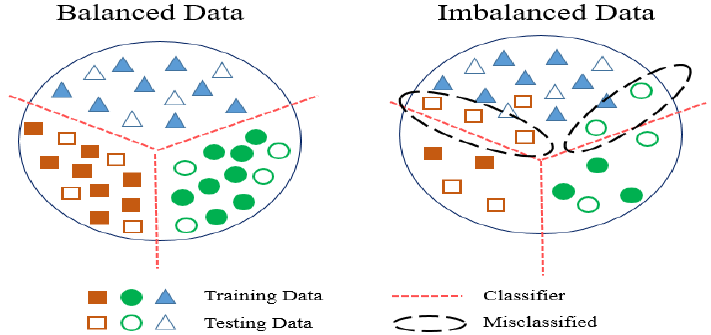
Figure 4. The Impact of Data Imbalance in the Fault Diagnosis Model.